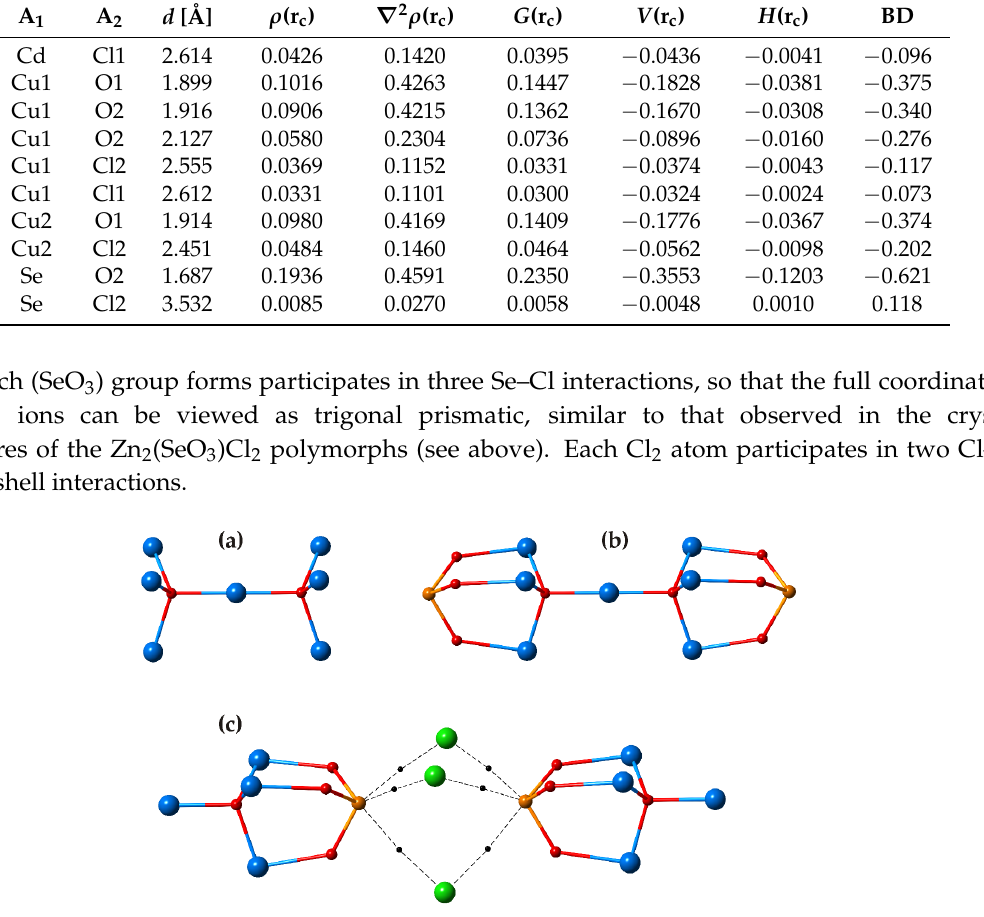
Table 6. Bond critical points in the crystal structure of burnsite, KCdCu 7 O 2 (SeO 3 ) 2 Cl 9 , and their properties.